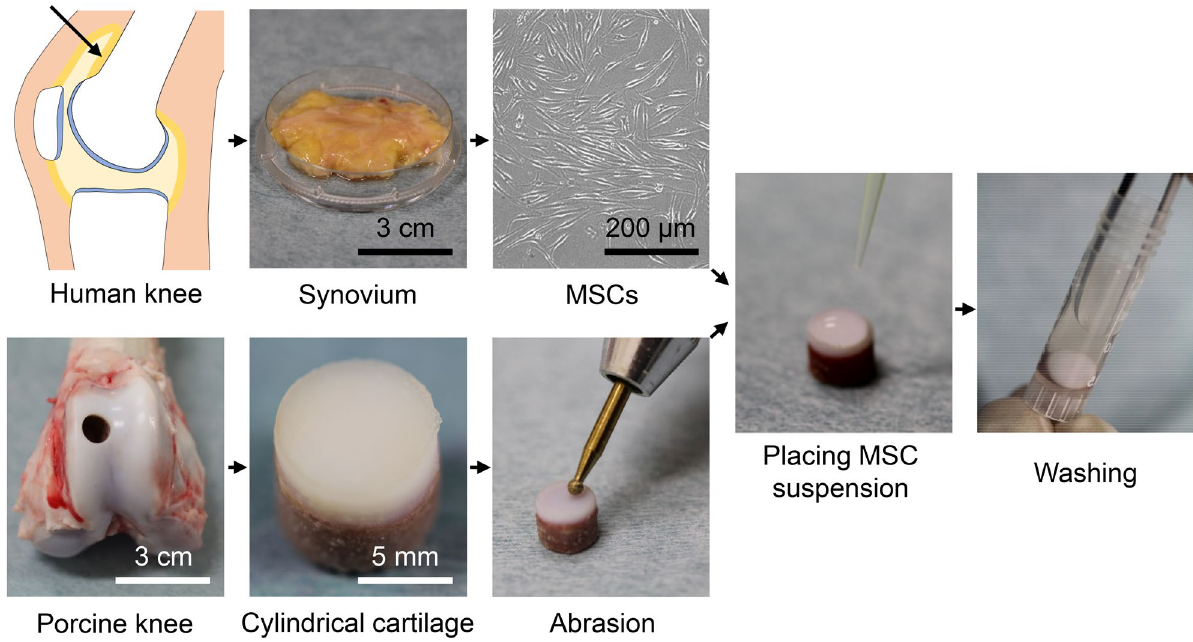
Figure 8. Scheme of the experiment. Mesenchymal stem cells (MSCs) were isolated from the synovium of the knee of a human patient with osteoarthritis. A cylindrical piece of cartilage was removed from the femur of a pig and its surface was abraded. The MSC suspension was placed on the cartilage surface, washed after a specified time, and the number and morphology of MSCs adhered to the surface of the cartilage were